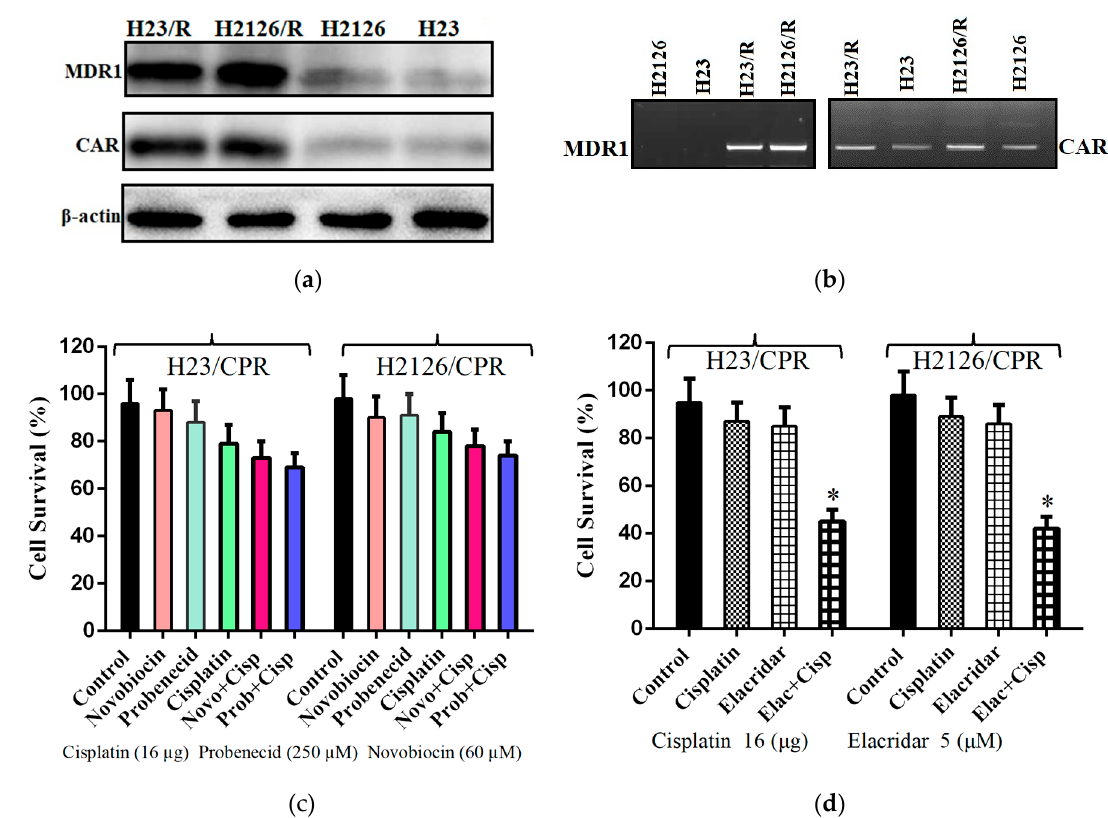
Figure 1. Cause of MDR phenotype in lung cancer cells. (a) Using anti-mdr1 antibody, Western blotting was performed. Results showed overexpression of MDR1 and CAR proteins in chemotherapeutic resistant cell lines of both lung cancer cells. Blot images were cropped for clarity of the presentation. (b) Reverse transcription PCR showing comparative mRNA levels of CAR and MDR1 in resistant and sensitive cells. (c) Cell viability assay to analyze the impact of Probenecid and Novobiocin treatments on resistance. (d) Sensitization of resistant cells to chemotherapy by elacridar treatment. Data are presented as the mean ± SD in (c) and (d), ( n = 3), * p <0.01, by two-tailed Student’s t-test.